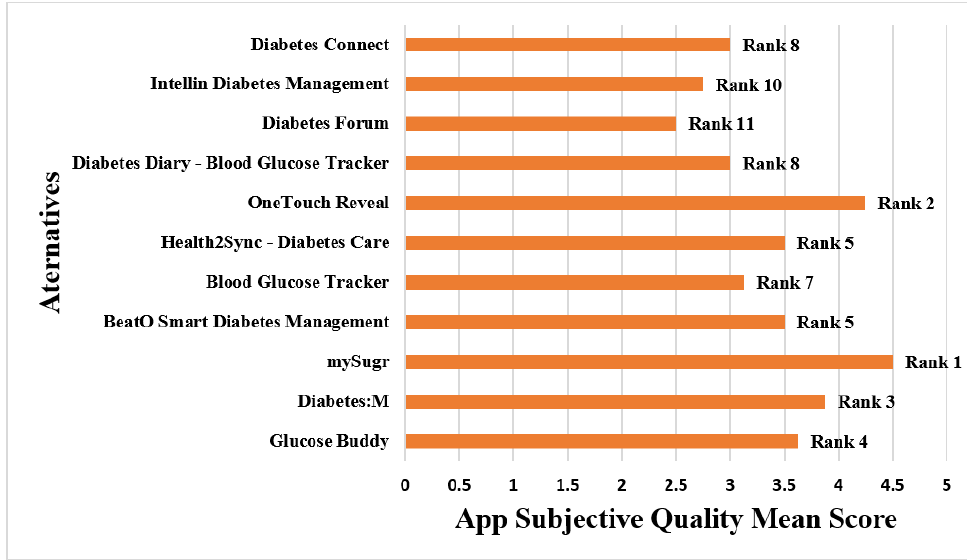
Figure 6. Rank of the applications based on the Application Subjective Quality Mean Score.